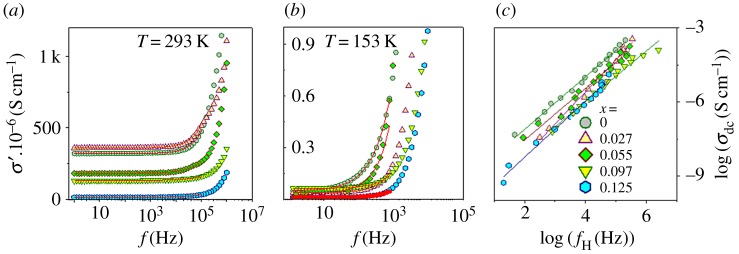
Frequency spectra of the real conductivity (σ′) at (a) 293 K, (b) 153 K and (c) Barton--Nakajima--Namikawa (BNN) plots for Cu1–xFexO (0 ≤ x ≤ 0.125). The solid lines are obtained from the Jonscher Law fit of complex conductivities.